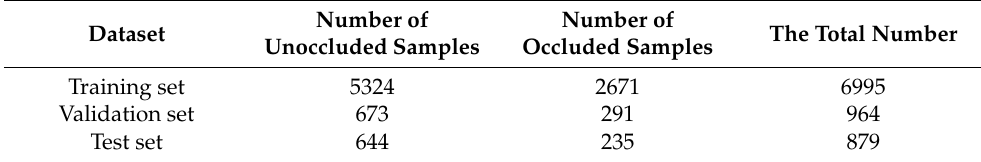
Table 1. Occlusion and quantity of